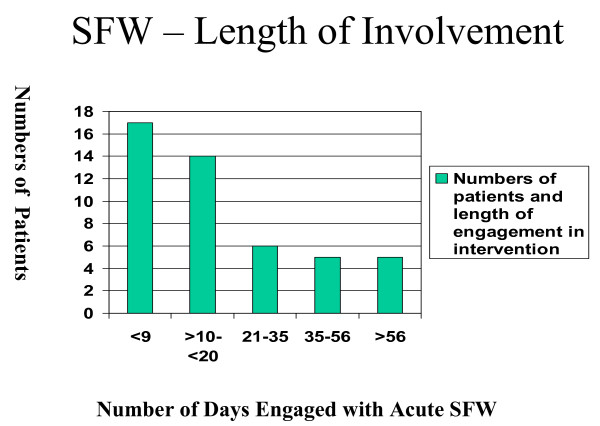
Categorical amounts of weight change in patients.